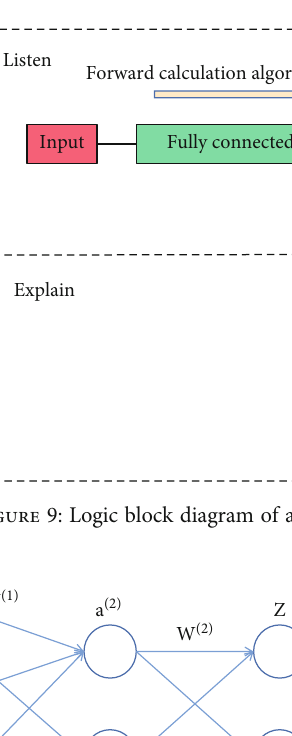
Figure 8: Basic instructional design according to ICAP classi fi cation.